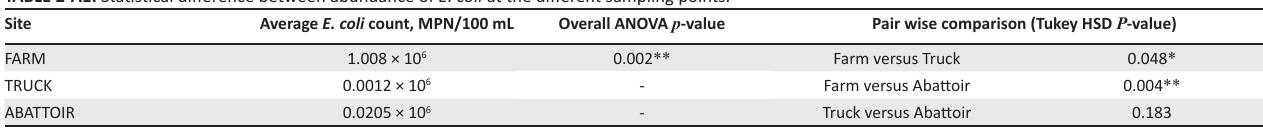
TABLE 2-A1: Statistical difference between abundance of E. coli at the different sampling points.